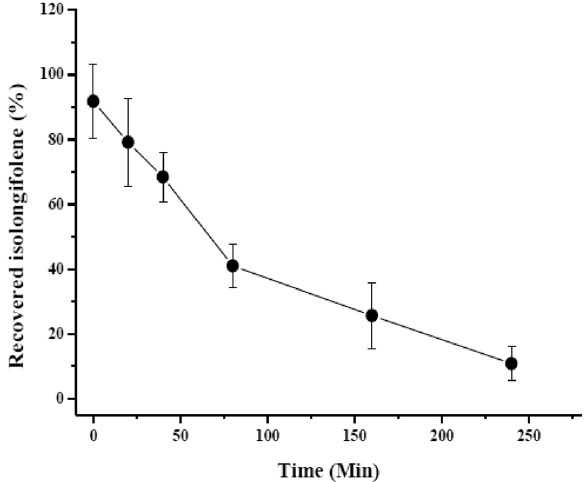
Figure 8. Plasma stability studies ofICN-K04 at different time intervals.